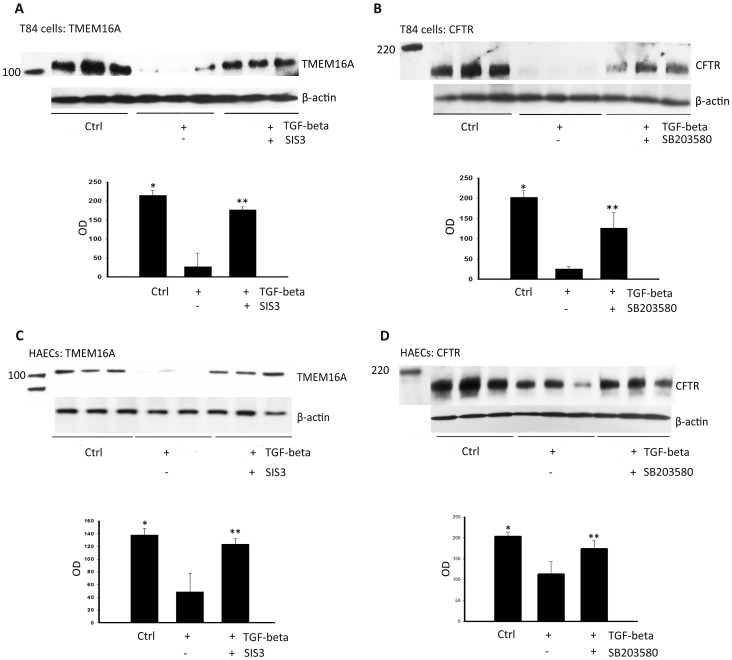
Rescue of TGF-beta-downregulated TMEM16A expression by a Smad3 inhibitor (SIS3) and CFTR expression by a p38 MAPK inhibitor (SB203580).T84 cells and HAECs were treated with either TGF-beta and SIS3 (5 µM, A and C) or TGF-beta and SB203580 (10 µM, B and D) for 48 h prior to lysis and immunoblot for TMEM16A (A and C) or CFTR (B and D). For each cell type, the upper gel panels show TMEM16A (A and C) or CFTR (B and D) detection from three replicate samples (with TGF-beta and either SIS3 or SB203580). SIS3 increased TMEM16A expression and SB203850 increased CFTR expression from TGF-beta-treated T84 cells and HAECs. The lower panels are summary densitometry data. T84 cells: *P<0.0002 for TMEM16A and CFTR control vs TGF-beta. **P<0.0007 for CFTR and TMEM16A + SB203580 and TGF-beta vs TGF-beta alone. HAECs: *P<0.035 for TMEM16A and CFTR control vs TGF-beta. **P<0.05 for CFTR and TMEM16A + SB203580 and TGF-beta vs TGF-beta alone.